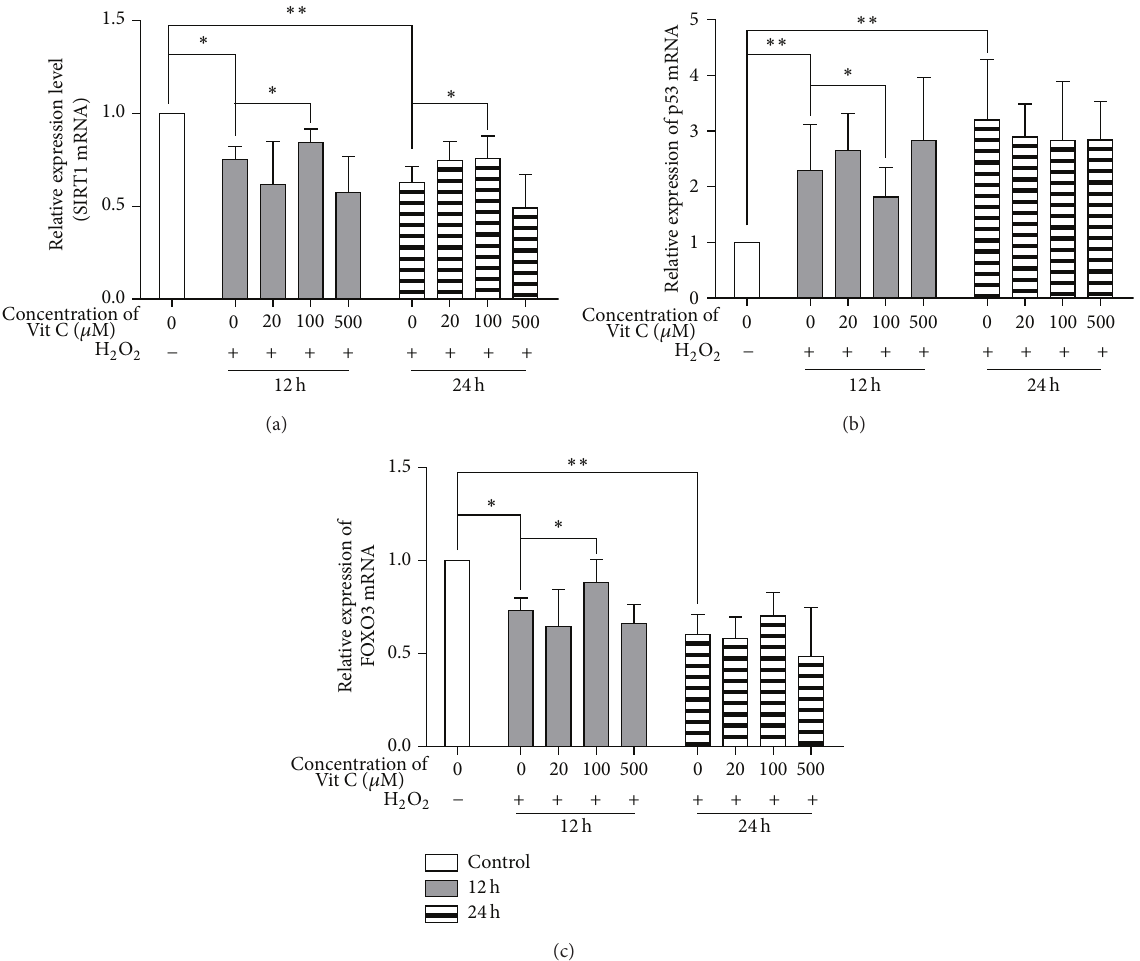
Figure 2: Vit C resulted in the dysregulation of SIRT1, p53, and FOXO3 during oxidative stress in ARPE-19 cells. ARPE-19 cells were treated with indicated methods. The expression of SIRT1 (a), p53 (b), and FOXO3 (c) mRNA was detected by qRT-PCR. Ct values were normalized by 2 −ΔΔ Ct method as relative quantification. Bars represented mean ± SD of three independent experiments. ANOVA was performed to analyze the differences statistically. Statistical significance was expressed as ∗ 𝑃 < 0.05 and ∗∗ 𝑃 < 0.01